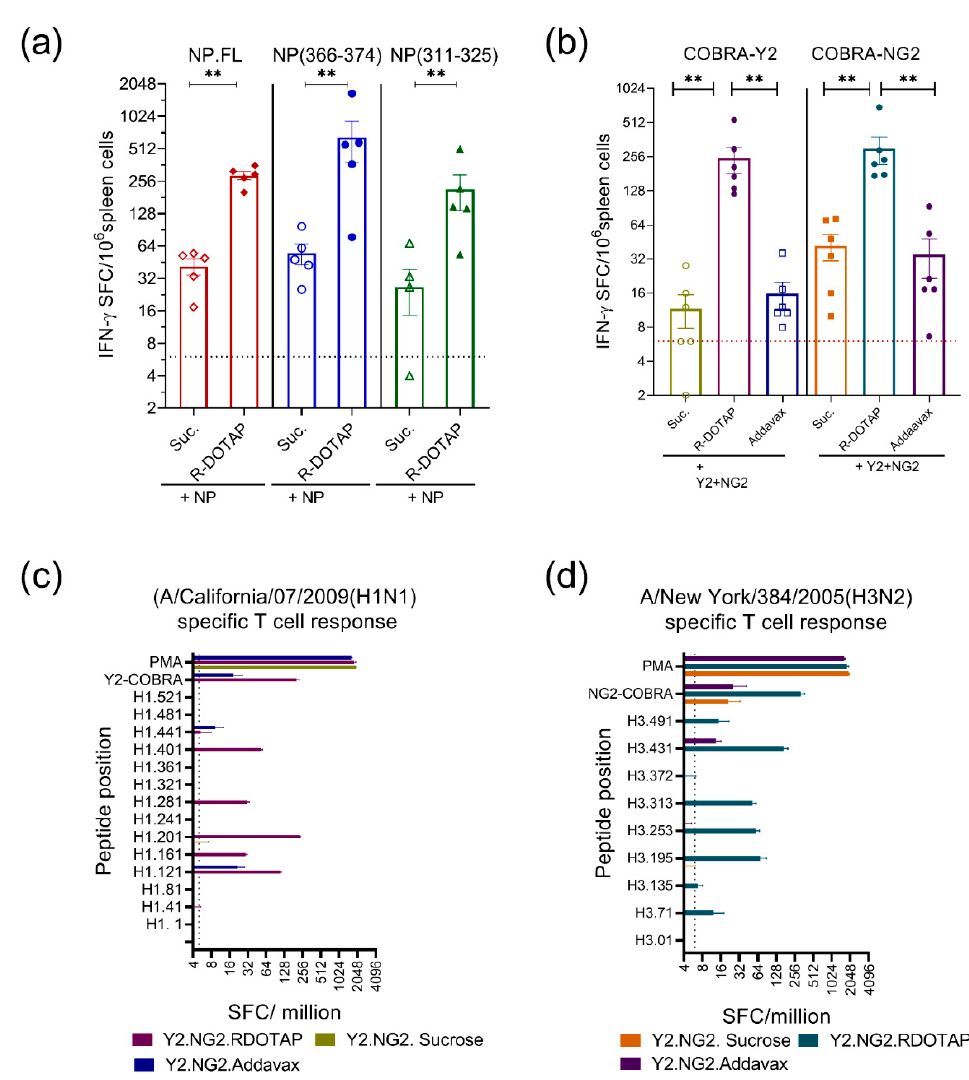
Figure 2. Recombinant influenza protein formulated with R-DOTAP nanoparticles induced potent antigen-specific T-cell immune responses. Groups ( a ) of C57BL/6J ( n = 5) mice were subcutaneously immunized on day 0 and day 7 with two doses of vaccine formulations containing recombinant influenza NP (PR8) (5 µ g/dose) formulated with R-DOTAP nanoparticles (R-DOTAP) or sucrose buffer (sucrose). Splenocytes isolated 7 days after second vaccine were stimulated overnight with NP (NP.FL), NP (366–74) CD8 T-cell epitope or NP (311–25) CD4 T-cell epitope and IFN- γ producing cells were measured using an ELISpot assay. Groups ( b – d ) of BALB/cJ ( n = 6) mice were intramuscularly injected on day 0 and day 21 with bivalent vaccine formulations containing COBRA-NG2 (H3) (3 μ g/dose) and COBRA-Y2 (H1) (3 μ g/dose) formulated with R-DOTAP nanoparticles or sucrose buffer (sucrose). Splenocytes isolated 7 days after second vaccine were stimulated overnight with recombinant COBRA-Y2 or COBRA-NG2 proteins ( b ) or with pools of 8–10 overlapping peptides derived from A/California/07/2009 (H1N1) ( c ), A/New York/384/2005 (H3N2) HA ( d ) or PMA/Ionomycin (PMA) and IFN- γ -producing cells in spleens from vaccinated mice were measured using an ELISpot assay. Data represent mean ± SEM spot forming cells (SFC) in each mouse ( a , b ) or pools from each group ( c , d ). Dotted lines ( a – d ) in each graph indicates average SFC count in the background no peptide wells. ( a , b ) Comparisons between sucrose alone or R-DOTAP groups was performed using Student’s t -test (unpaired-two tailed). ** p ≤ 0.05. Data shown are representative of two independent repeat studies. To test the potential immunogenicity of a bivalent H1/H3 vaccine, mice were vac- cinated with R-DOTAP-Y2NG2 and T-cell responses assessed using overlapping peptides